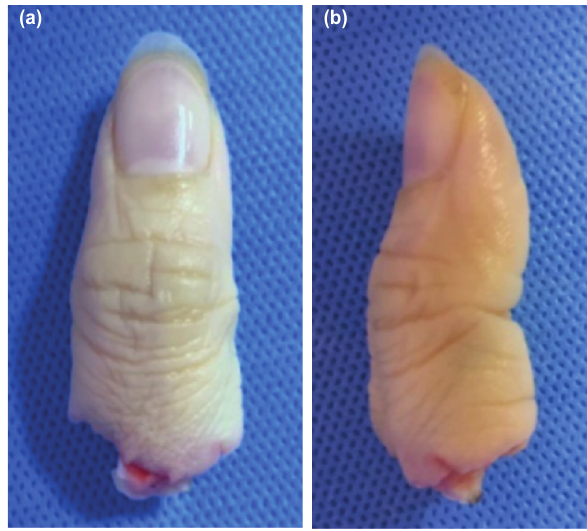
(a) and (b) Anteroposterior and lateral view of amputated left thumb, at the level base of proximal Fig. 1: